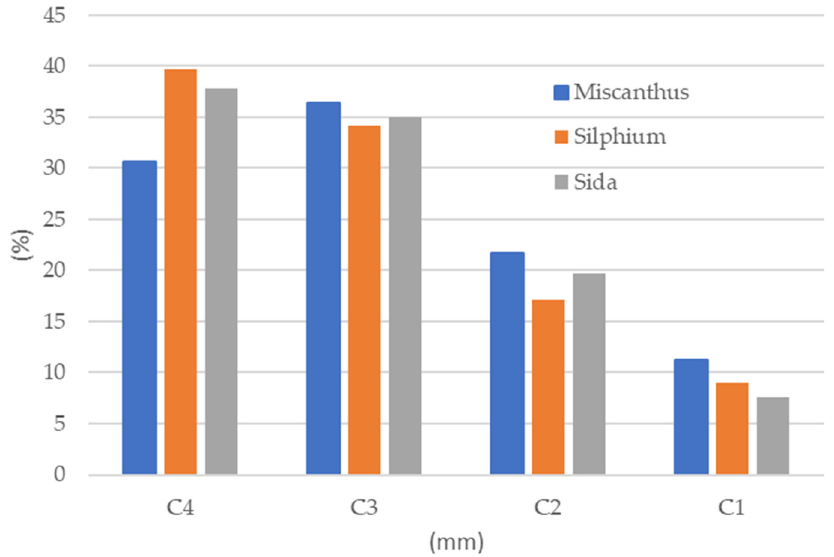
Figure 5. Particle size distribution.